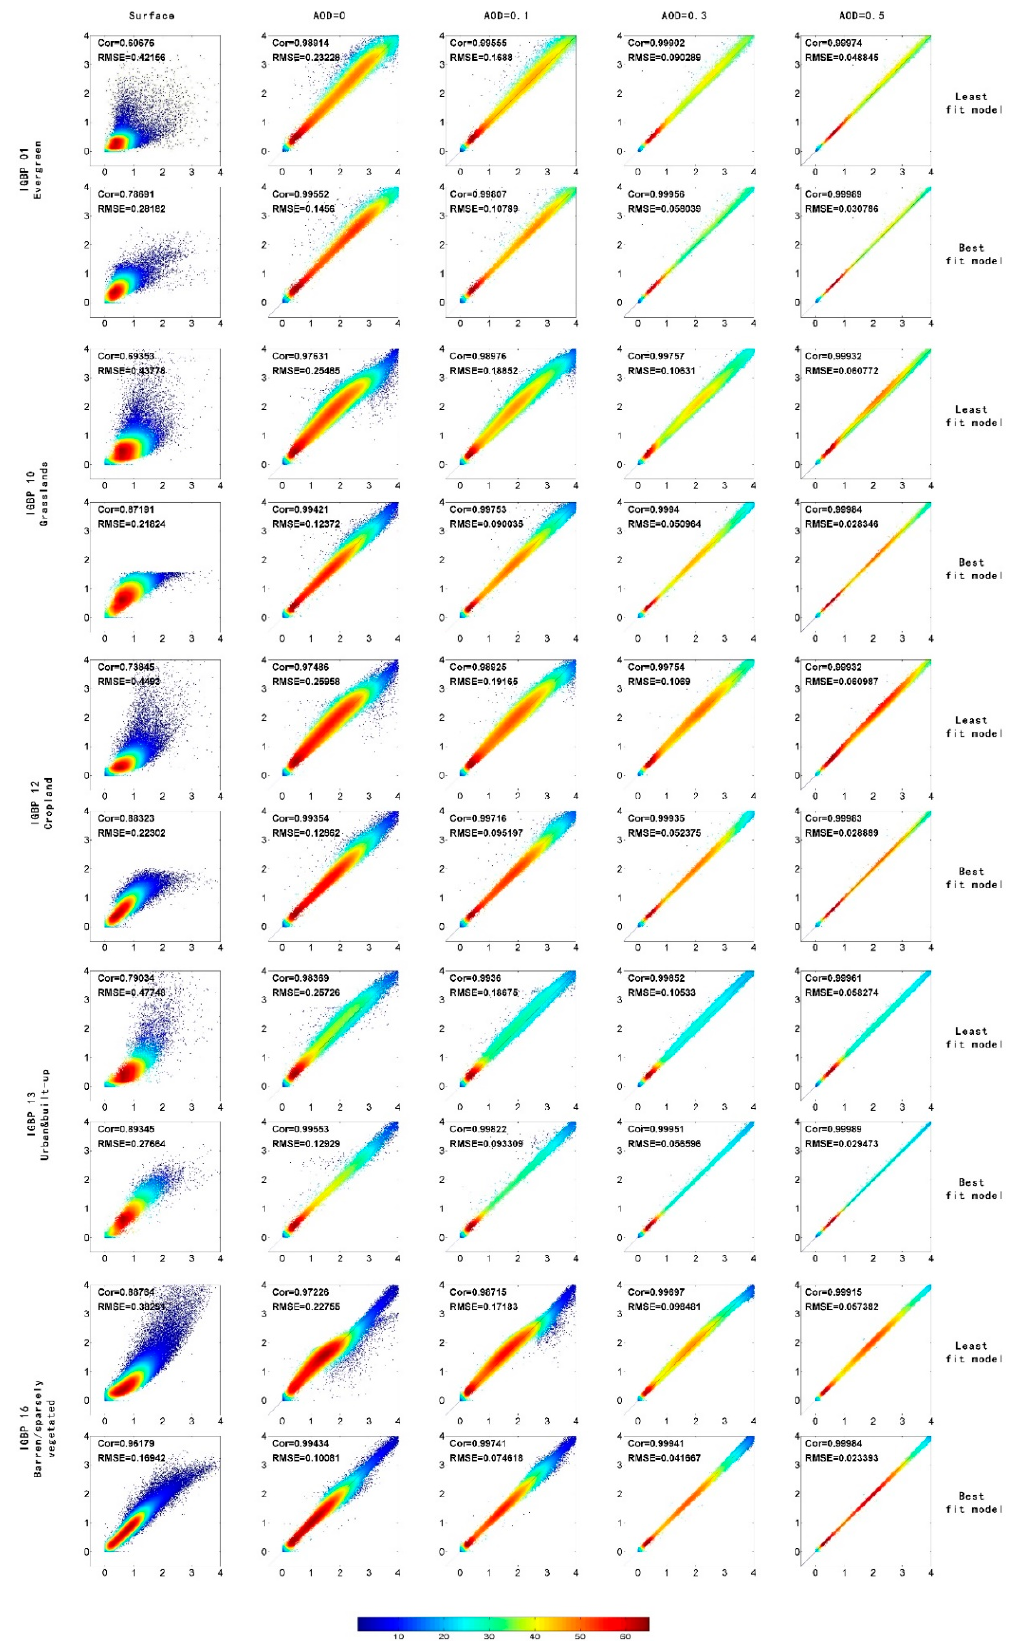
Figure 9. Effect of different BPDF models on TOA polarized reflectance under different aerosol optical depth conditions.